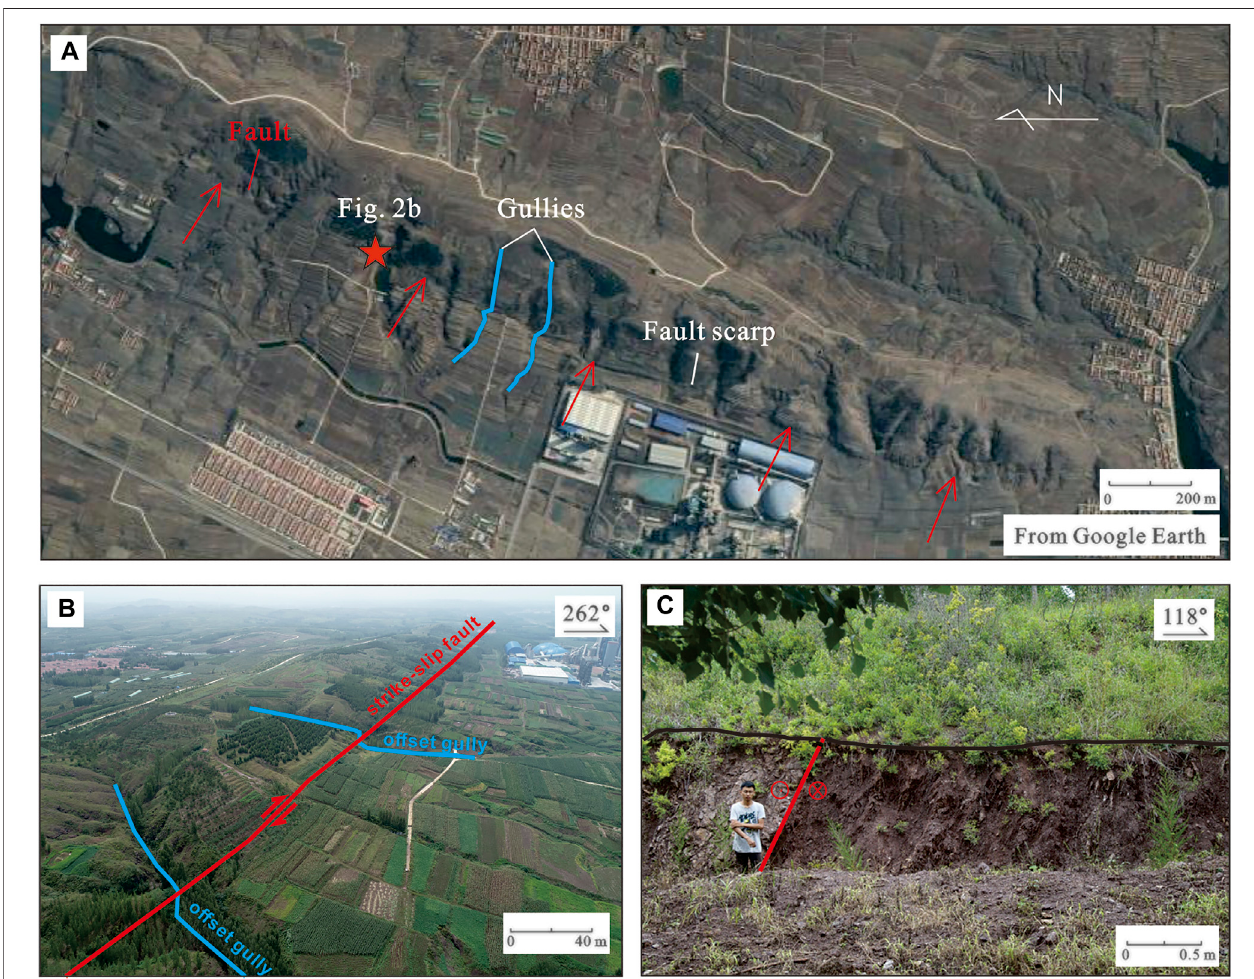
FIGURE 2 | (A) : Seismic geomorphology (e.g., fault scarp and offset gullies). along the NAJF; (B) : Offset gullies along the NAJF; (C) : Outcrop of the NAJF. The locations of Figures 2A,C are shown in Figure 1C .